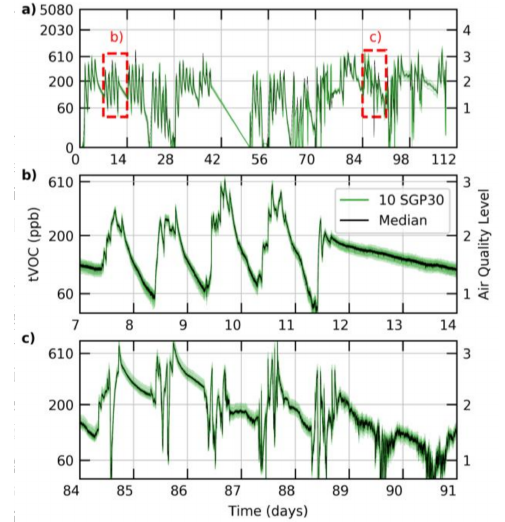
Figure 7. Total VOC (tVOC) signal in a typical meeting room, recorded with 10 different SGP sensors (green) over a period of about 4 months ( a ); the median is given as black line. The two red rectangles indicate the position of the zoom-ins provided in panels ( b , c ). On the secondary y-axis, the maximum values of the corresponding air-quality levels are indicated